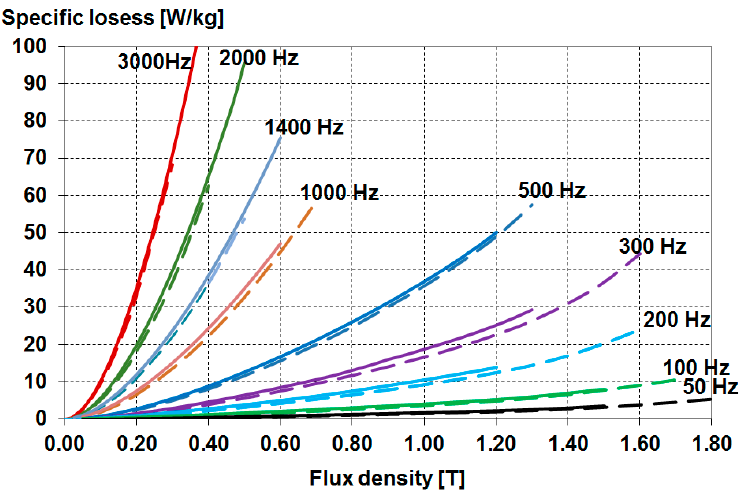
Figure 13. Measured loss characteristics of the M270-35A sheet for 10 mm wide samples cut with a laser in a wide frequency range; rectangular sample (solid line), toroidal sample (dashed line).